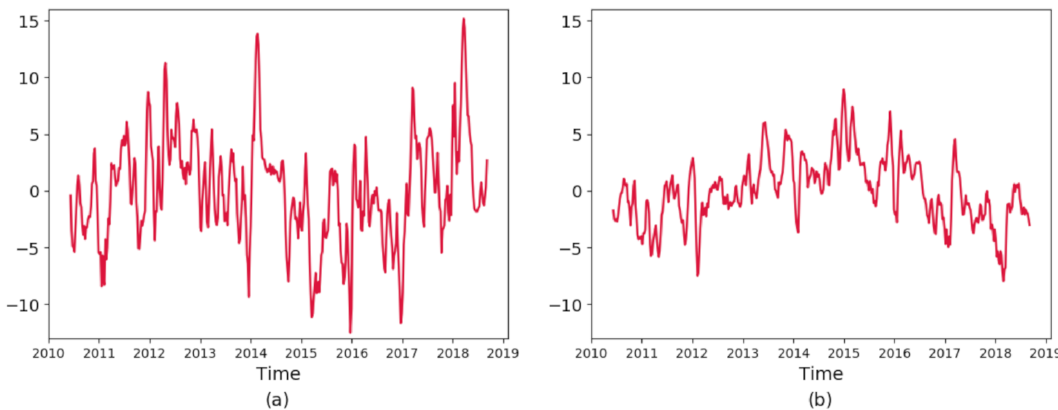
Figure 3. First ( a ) and second ( b ) time component of the weekly GPS Up coordinate